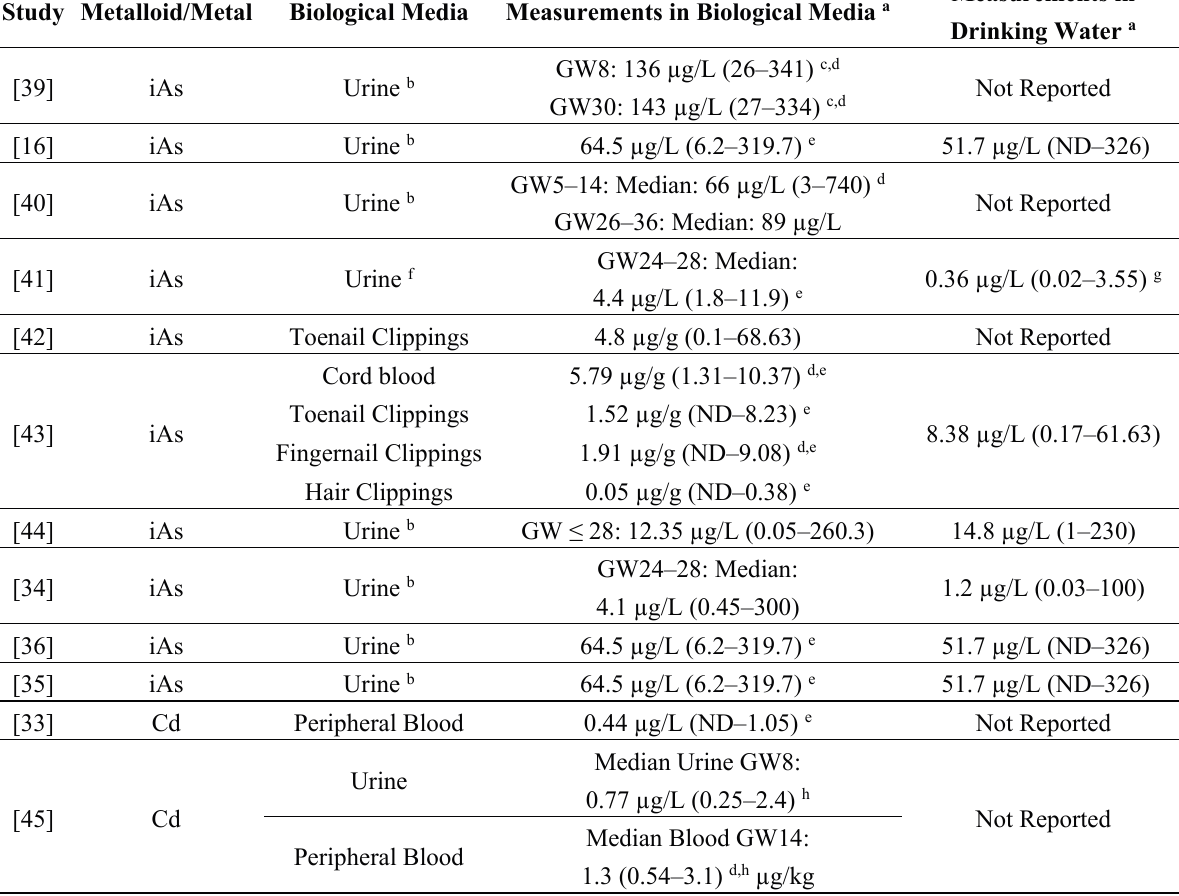
Table 1. iAs and Cd levels measured in human pregnancy cohort